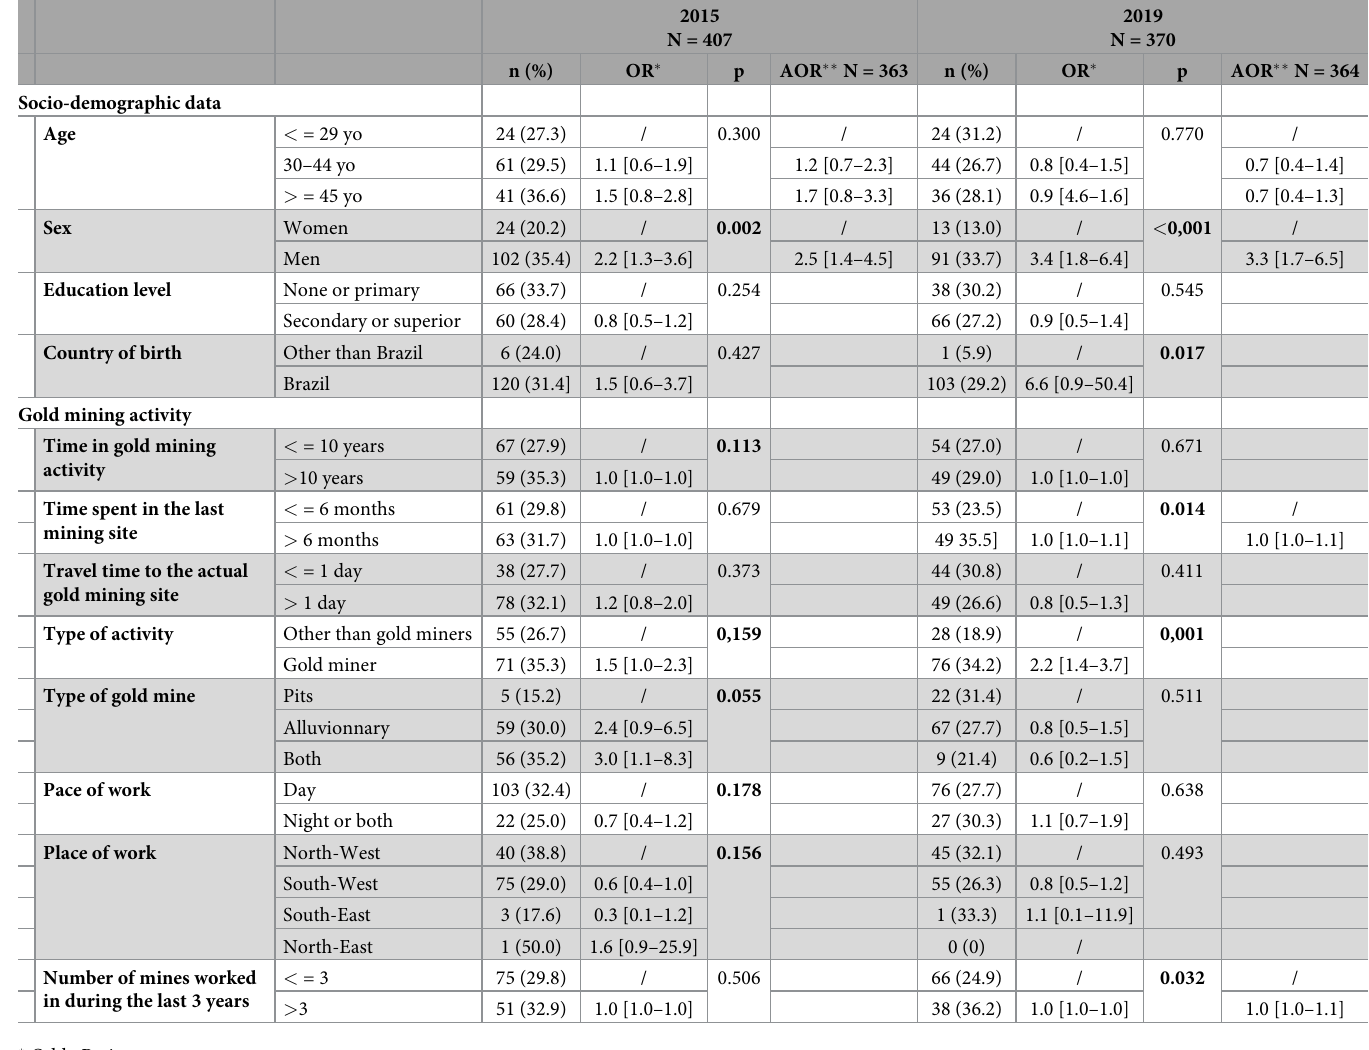
Table 4. Factors associated with positive leptospirosis serology among the population of illegal gold miners included in the 2015 and 2019 studies (univariate and multivariate